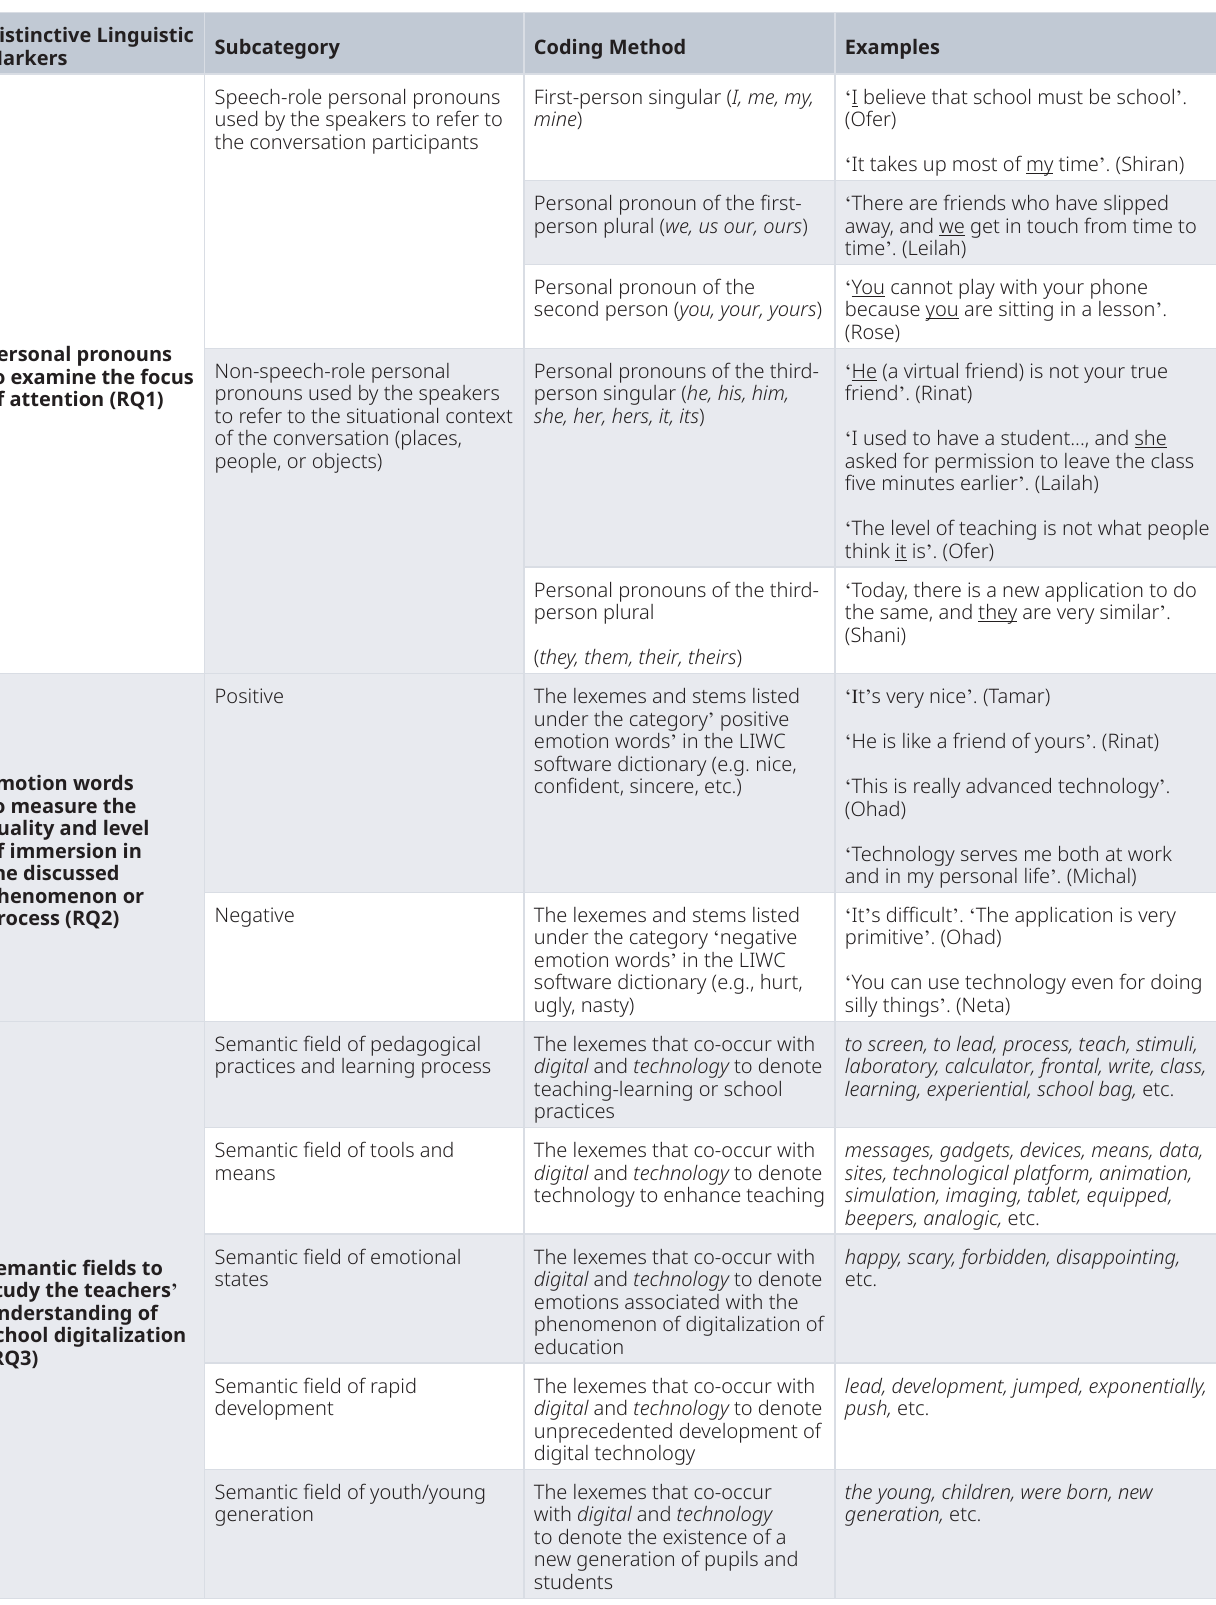
Table 2. Distinctive linguistic markers, subcategories, coding method, and examples. Distinctive Linguistic